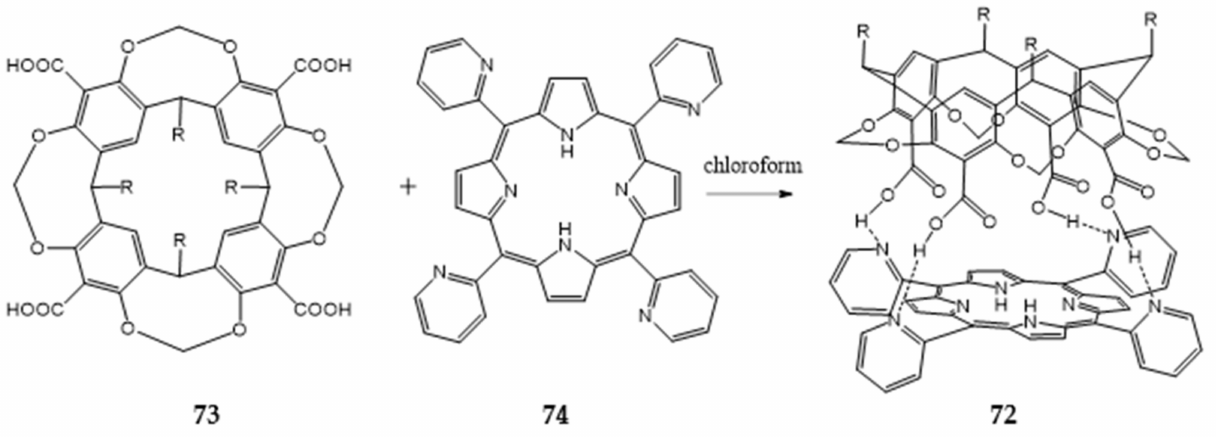
Figure 13. The curve of 1 H-NMR titration of receptor 69 by the C 70 fullerene in C 6 D 6 (300 MHz, 298 K) [44].